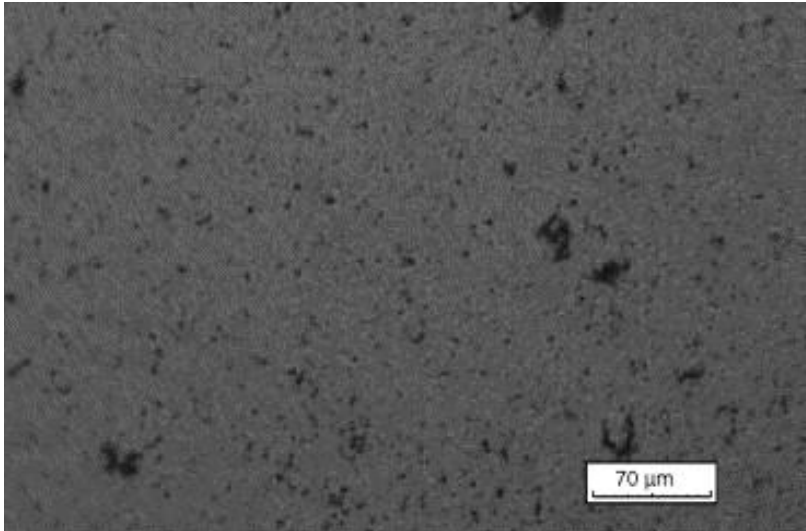
Figure 4. Differential coefficient interference pattern of Al 2 O 3 -particle distribution in the modified membrane. Reprinted with permission from [69]. Copyright (2006) Elsevier B.V.